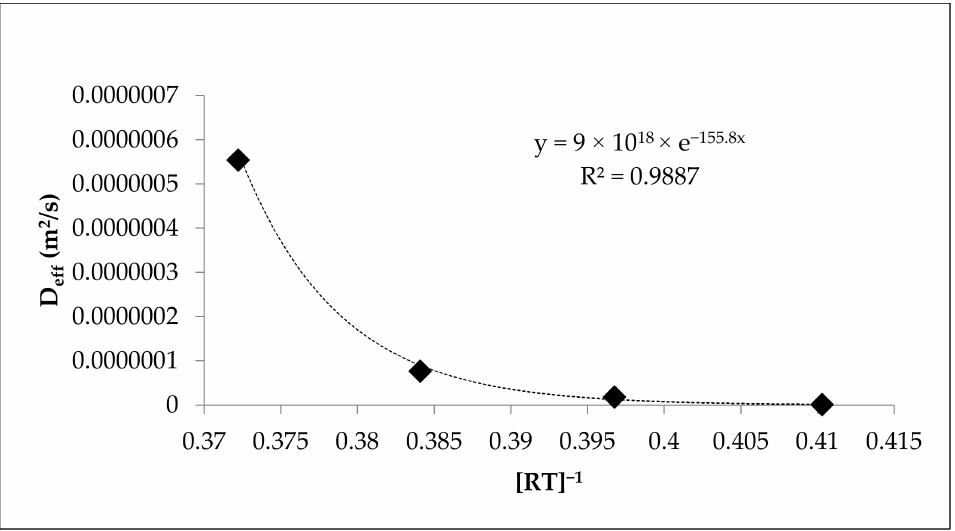
Figure 4. The Arrhenius equation and the relationship between D eff and temperature.